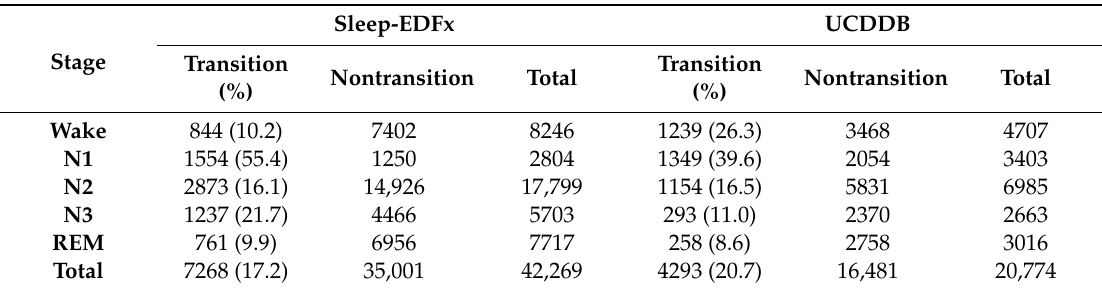
Table 1. Details on the datasets used in this study.